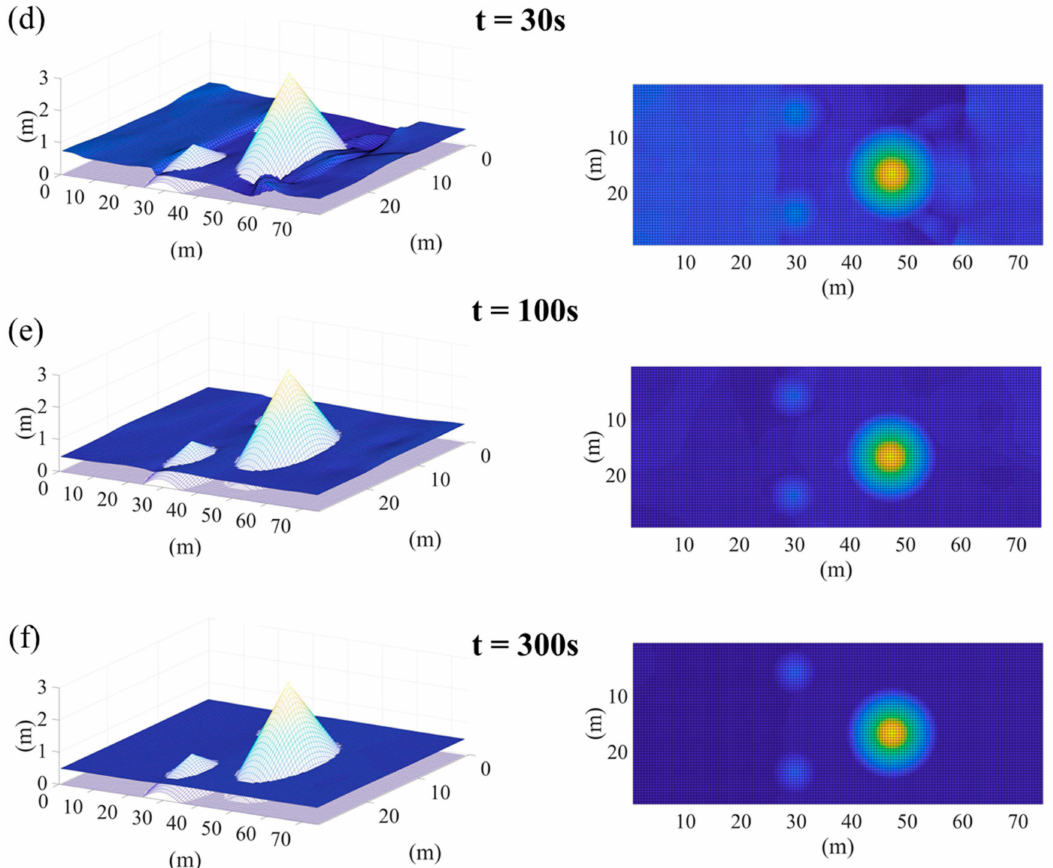
Figure 11. Simulated flood evolution on a complex three-hump condition. ( a ) The flood starts to reach the first two low humps at 2 s; ( b ) the flood flows over the two low humps at 6 s; ( c ) the flood flows downstream of the high humps at 12 s; ( d ) the flood forms a higher flow depth downstream at 30 s; ( e ) there is some weak flow in the tank at 100 s; ( f ) the tank maintains a static condition at 300